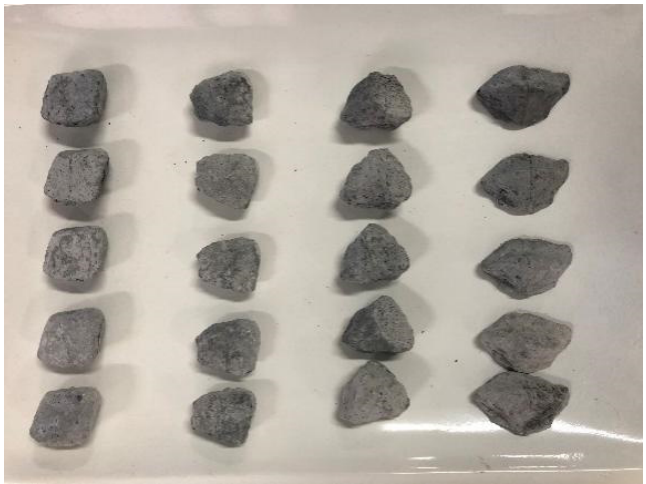
Figure 13. Prepared artificial aggregates.